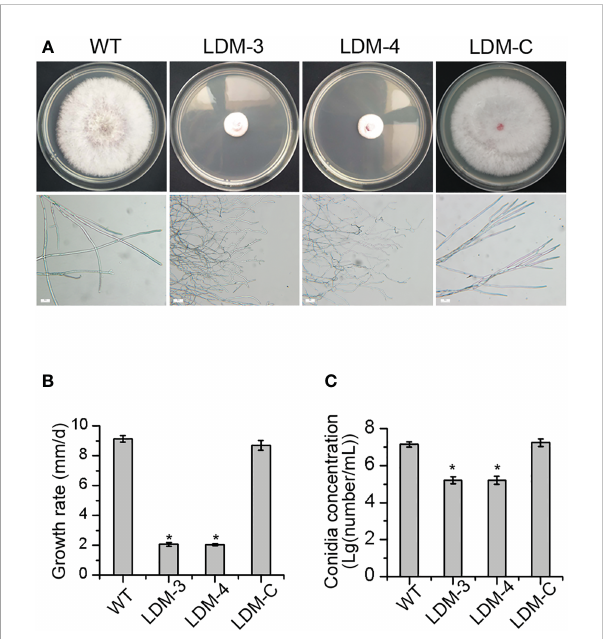
FIGURE 3 Effects of FpLaeB deletion on the morphology and conidiation of F pseudograminearum . (A) Colonies of wild-type and FpLaeB deletion mutant strains on potato dextrose agar (PDA) at 3 days post- inoculation. The photos of hyphal morphology were taken under a 200 times microscope. Bar = 20 m m. (B) Growth rate was presented by growth radius per day, which calculated radial growth between 2 and 3 dpi. (C) The logarithm of number of conidia per millilitre after 4 dpi in induced medium. Mean and standard deviation of data were calculated from three biological replicates. Statistical analysis was performed using Fisher ’ s least signi fi cant difference (LSD) in the Statistical Package for the Social Sciences (SPSS). Asterisks represent a signi fi cant difference between mutants and wild type ( p <